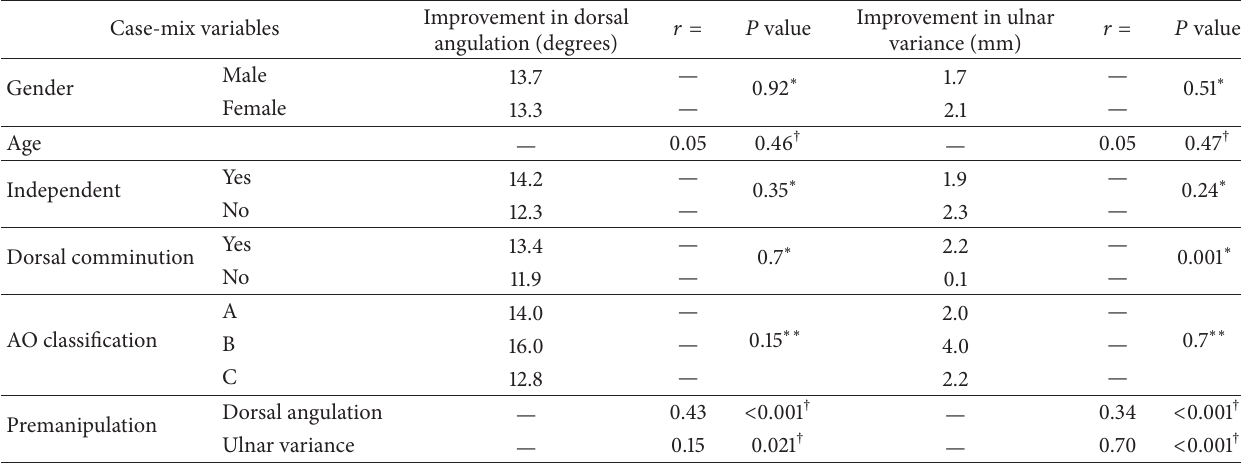
Table 3: Predictors of improvement in the dorsal angulation and ulna variance at 6 weeks.